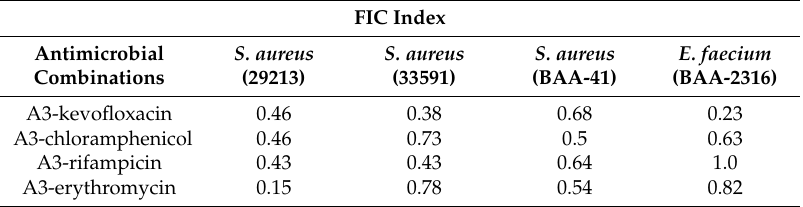
Table 5. List of all the A3-antibiotic combinations and their FIC indices. Results represent